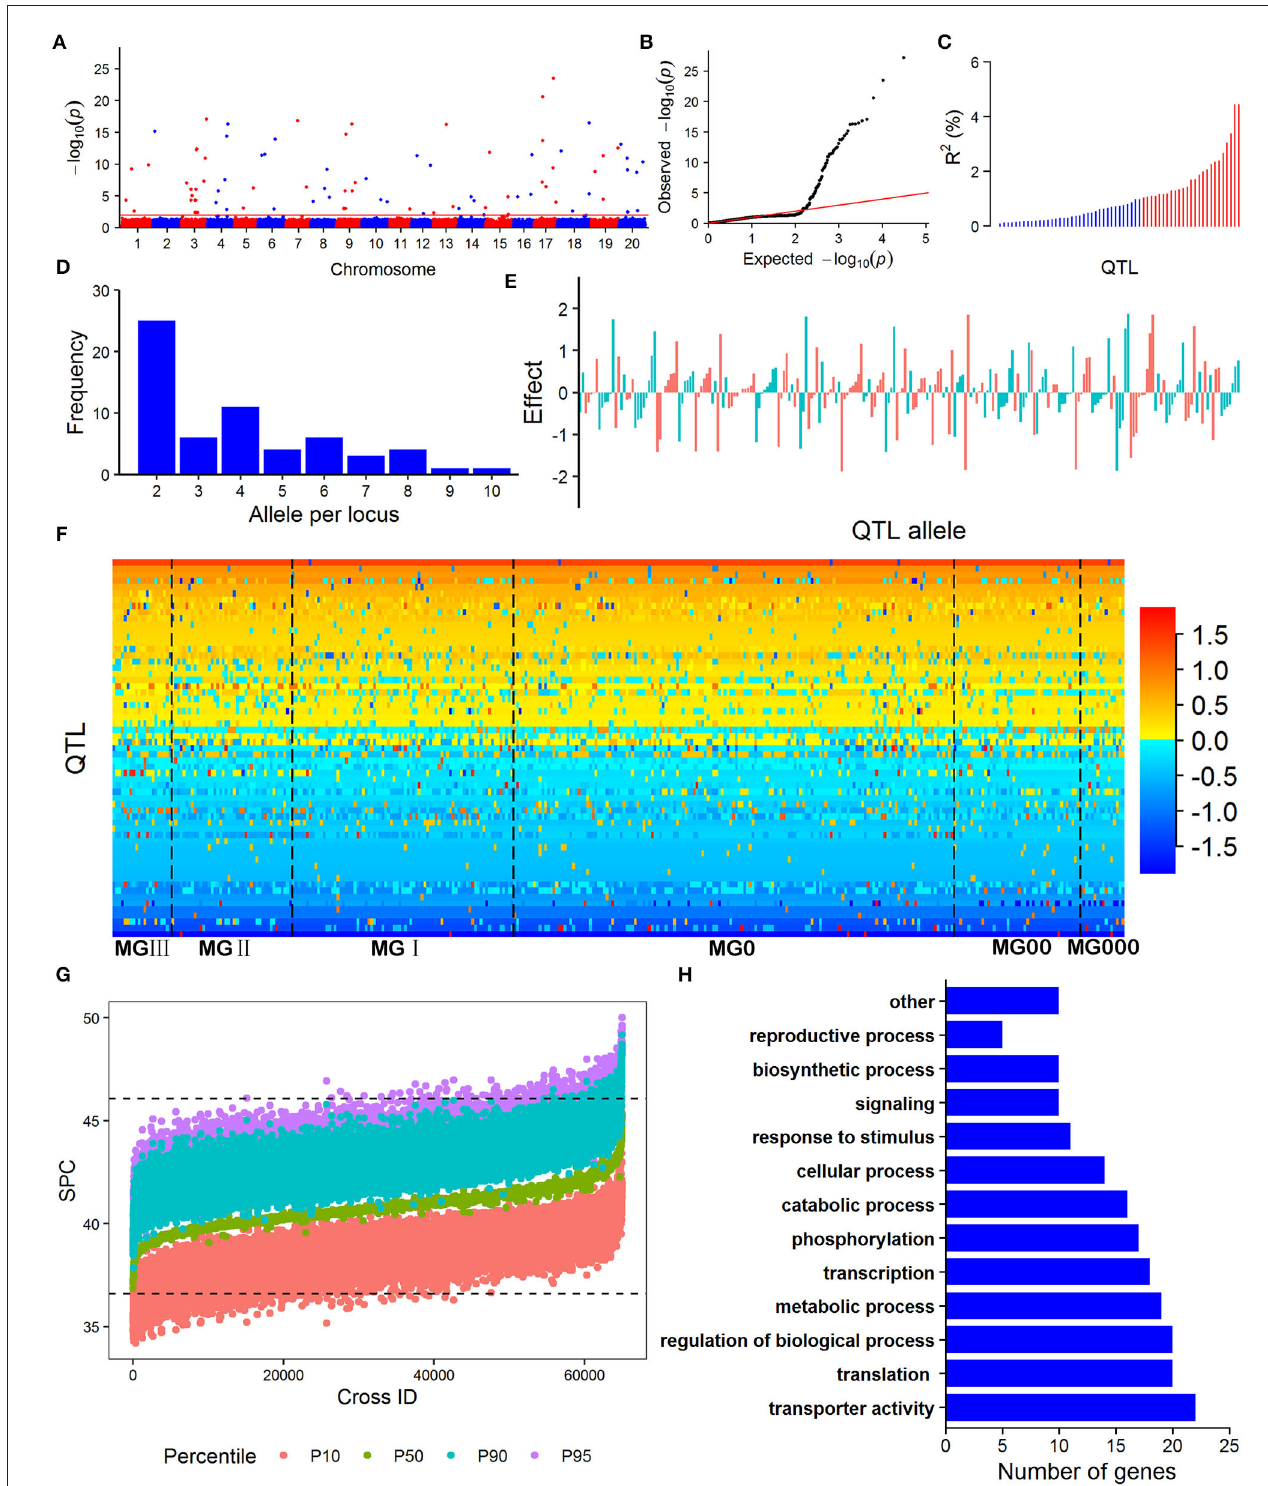
FIGURE 1 | The SPC QTL-allele information of the Northeast China soybean germplasm population obtained from RTM-GWAS. (A) Manhattan plot; (B) Quantile - quantile plot; (C) The phenotypic contribution of the 61 main-effect QTLs, blue bars denote small-contribution QTL ( R 2 < 1%), red bars represent large-contribution